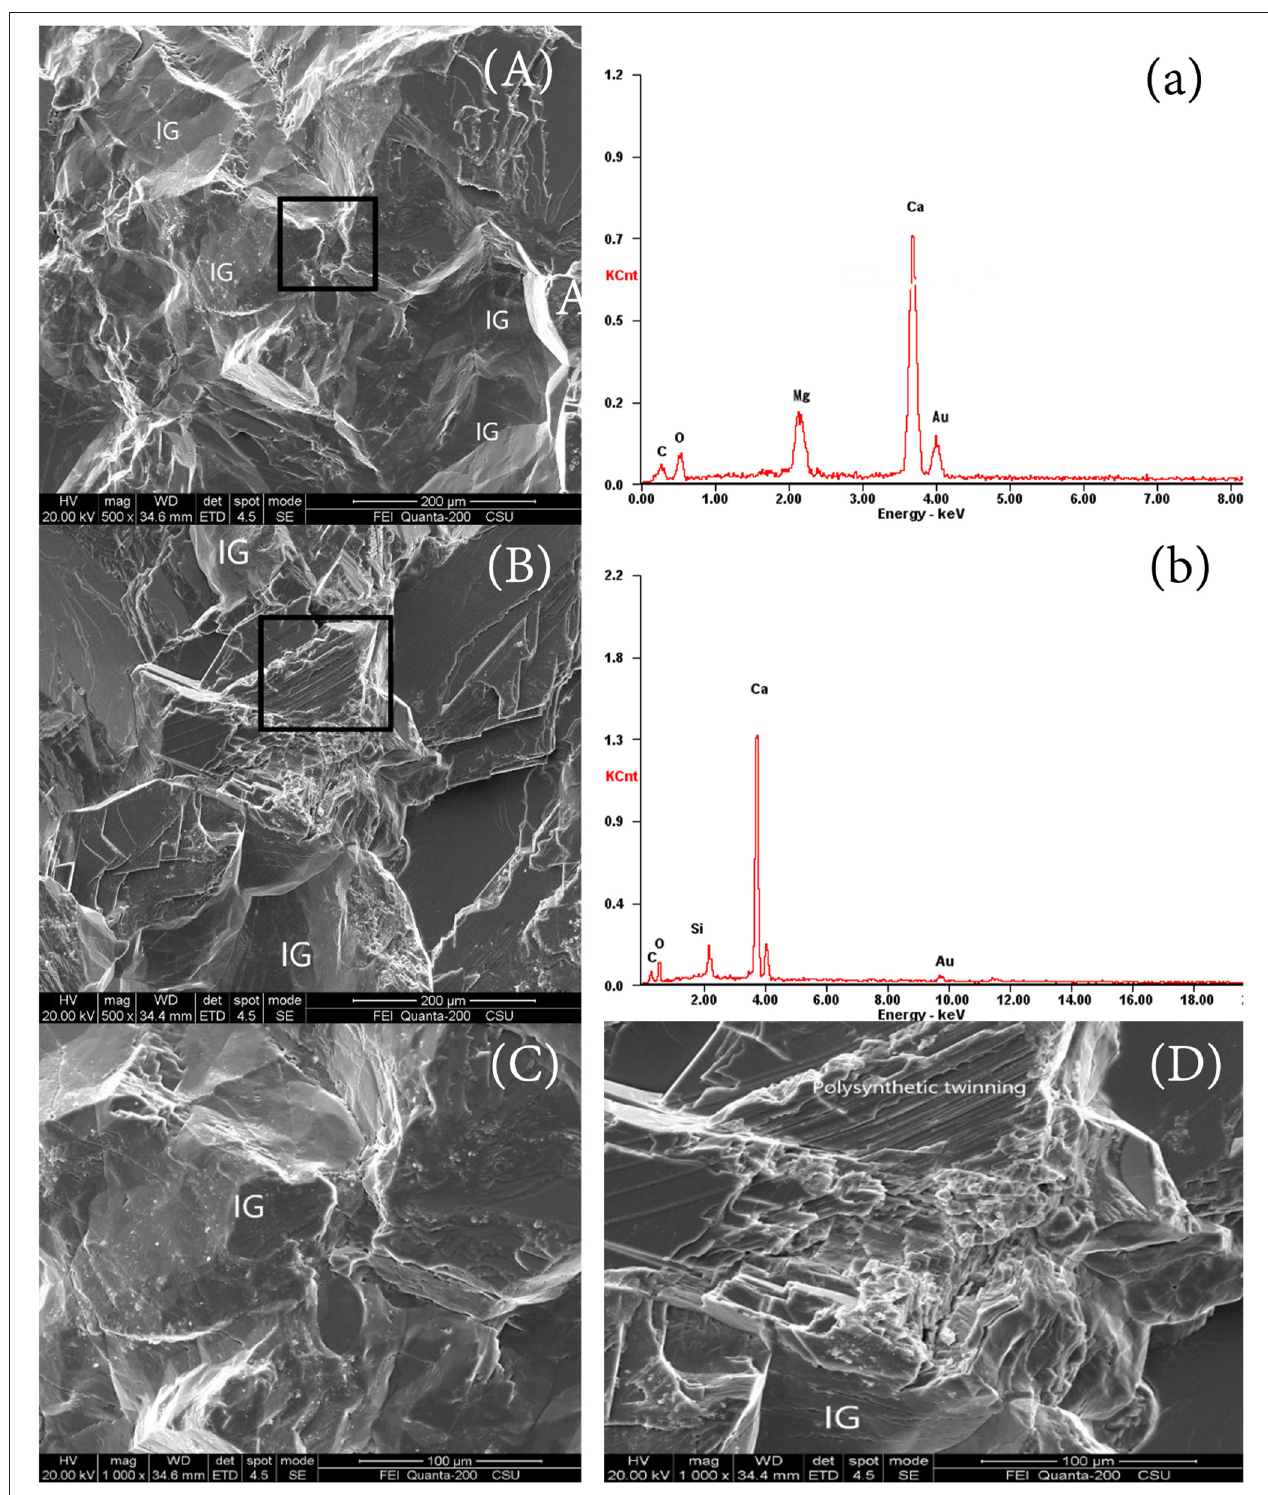
FIGURE 6 | SEM photos of the fracture surfaces for marble under the Brazilian split test. (a,b) The energy spectrogram corresponding with the black square in (A,B) and its mineral composition is dolomite and calcite, respectively; (C,D) represents the high magnification morphology of the black square in (A,B) , respectively.